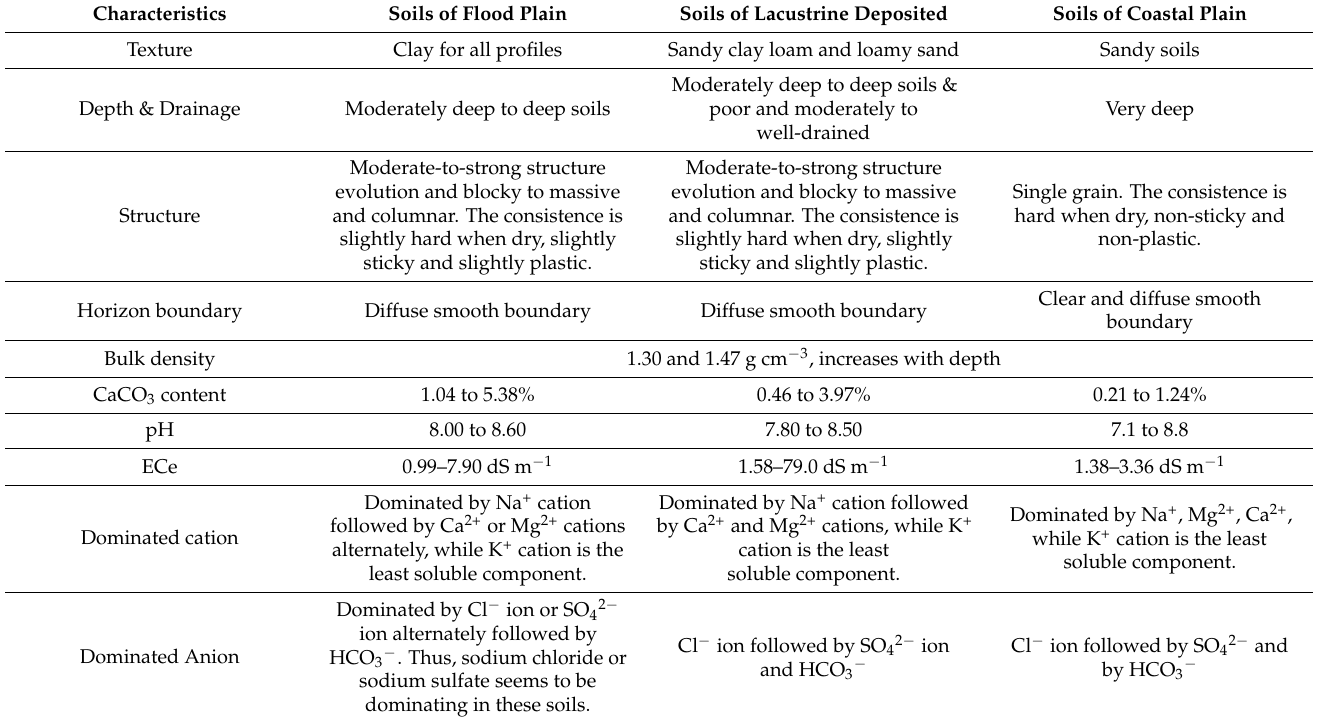
Table 5. Soil properties in the study